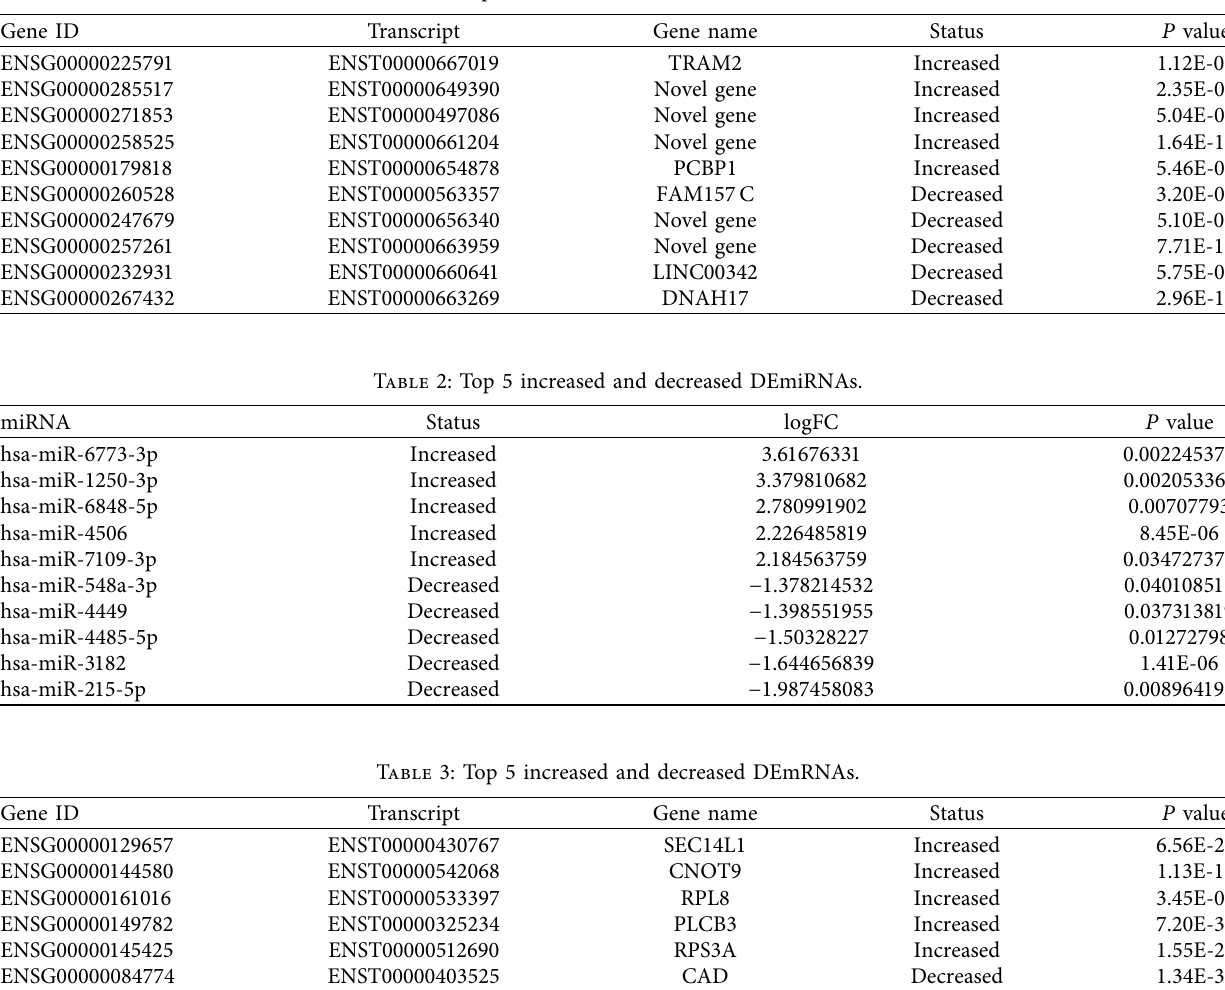
Table 1: Top 5 increased and decreased DElncRNAs.